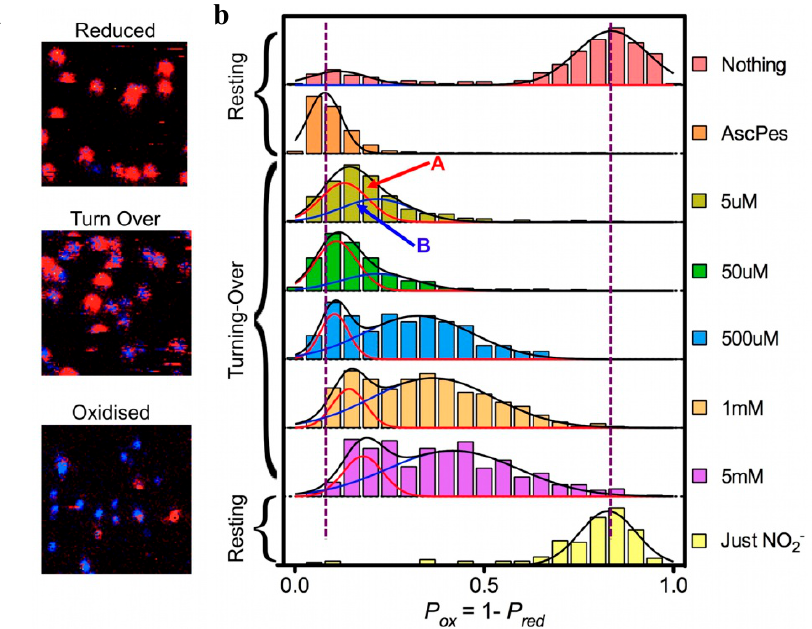
Figure 5. FLIM experiments on Ax-Nir-647N. ( a ): Part (7 × 7 μ m) of surface area scanned row by row from right to left and from top to bottom; pixel size 75 nm, dwell time per pixel 4 ms. Ax-NiR-647N was immobilized in an agarose gel on the surface of a glass cover slip [32], in the presence of 10 mm ascorbate and 100 nm PES (“Reduced”), 10 mm (“Turn Over”) and 5 mm NaNO2 ascorbate, 100 nm PES, and 500 mm NaNO 2 (“Oxidised”). After fitting, pixels were colored red (lifetimes > 2.5 ns) or blue ) was (lifetimes < 2.5 ns). For each spot the probability of finding the NiR reduced (P red calculated as the number of red pixels weighted by the total number of pixels in the spot. for freshly prepared enzyme in pH 7.5 buffer with no reductant or ( b ): Histograms of P ox oxidant present (“Nothing”); under reducing conditions (“AscPes”); under turnover conditions with amounts of NaNO varying from 5 µM to 5 mM; and under oxidizing 2 − ”). The histograms were each fit to a single Gaussian (“AscPES” conditions (“Just NO 2 − ”) or to a sum of two Gaussians for the other cases. Molecules and “Just NO 2 corresponding to Population A (reduction first) and B (binding first) are indicated by red and blue arrows,